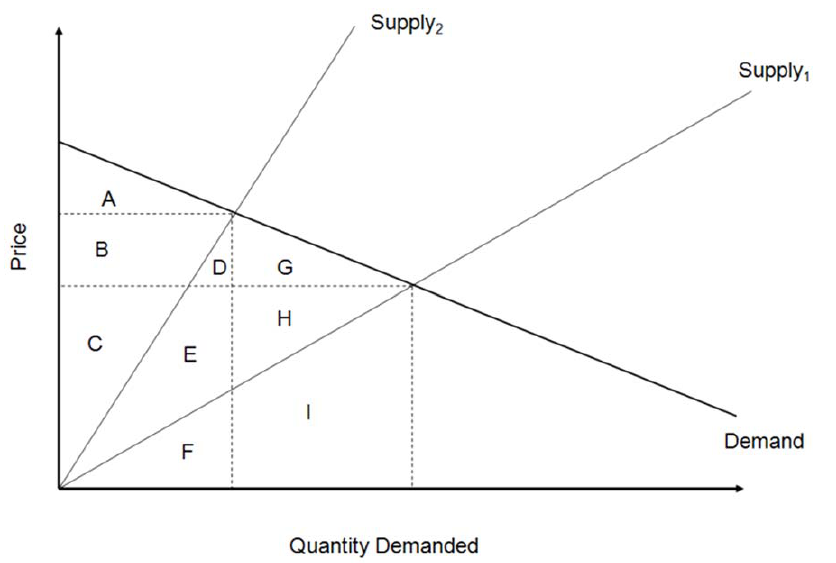
Figure 2. Benefit shift of conservation actions. Figure 2 illustrates how benefits are shifted with conservation action. Supply 1 represents the initial state of our system with no conservation action, and Supply 2 represents the new supply curve when land conservation is implemented.